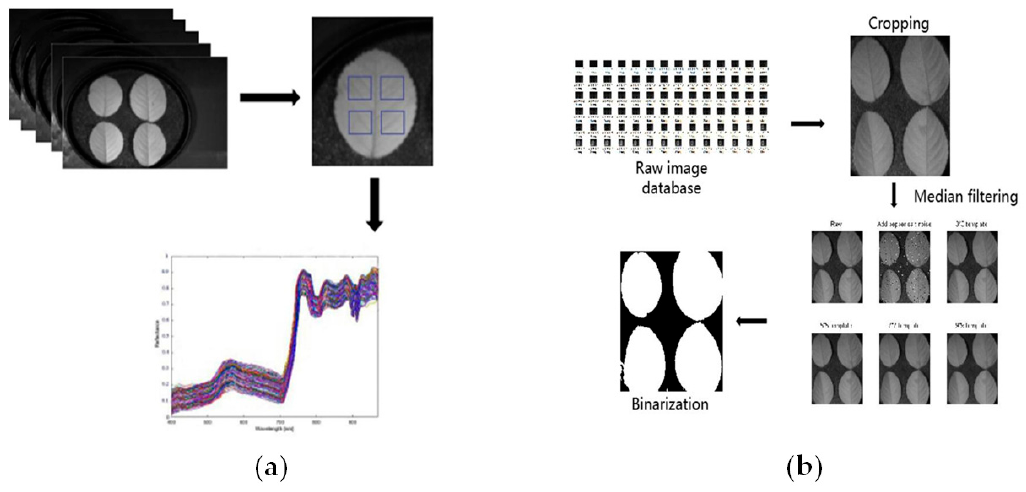
7 of 13 Figure 6. Schematic overview of the data procedures.